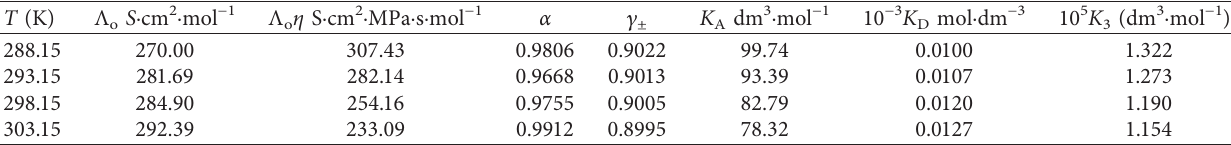
Figure 7: Variation of log Λ − 1 ) of for bulk and nano-CuCl · 2H o with l/ T (K 2 2 O in H 2 O. Table 4: Different association parameters (limiting molar conductance ( Λ o ), Fuoss–Shedlovsky parameter S ( z ) , degree of dissociation ( α ), activity coefficient ( c ± ), association constant ( K A ), dissociation constant ( K D ), triple ion association constant ( K 3 )) for bulk CuCl 2 · 2H 2 O in distillate H 2 O at 288.15, 293.15, 298.15, and 303.15 K in absence of CFT.